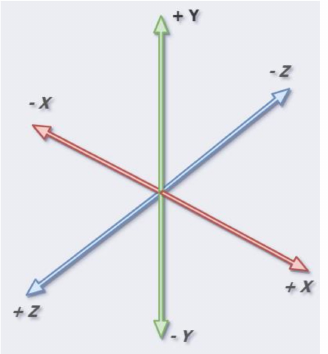
Figure 20. Coordinate system of